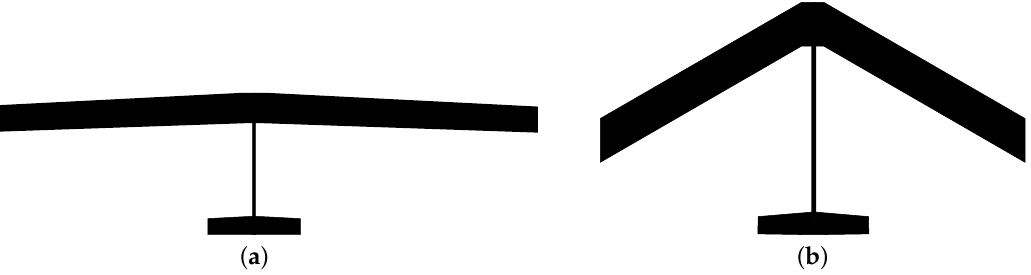
Figure 8. Single objective optimized plane forms. ( a ) Min flutter speed configuration, S = 4.0m 2 , AR = 22.0, TR = 0.84, Λ = 2.2deg; ( b ) Min flutter frequency configuration, S = 3.6m 2 , AR = 9.5, TR = 1.0, Λ =